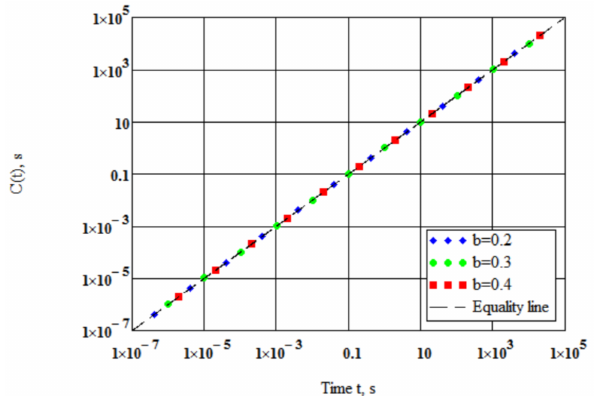
Figure 1. The convolution product of relaxation modulus and creep compliance. As it is seen, Equations (1) and (3) include three parameters and all of them have physical